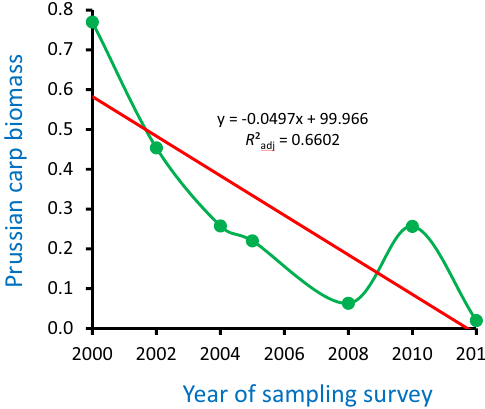
Figure 3. Prussian carp biomass decline in the recovered course of the Ner River, Poland, over the fish sampling period of 2000–2012. Green dots are Hellinger transformed values of Carassius gibelio —Prussian carp biomass in each of the sampling surveys. Red line is linear regression of the values.